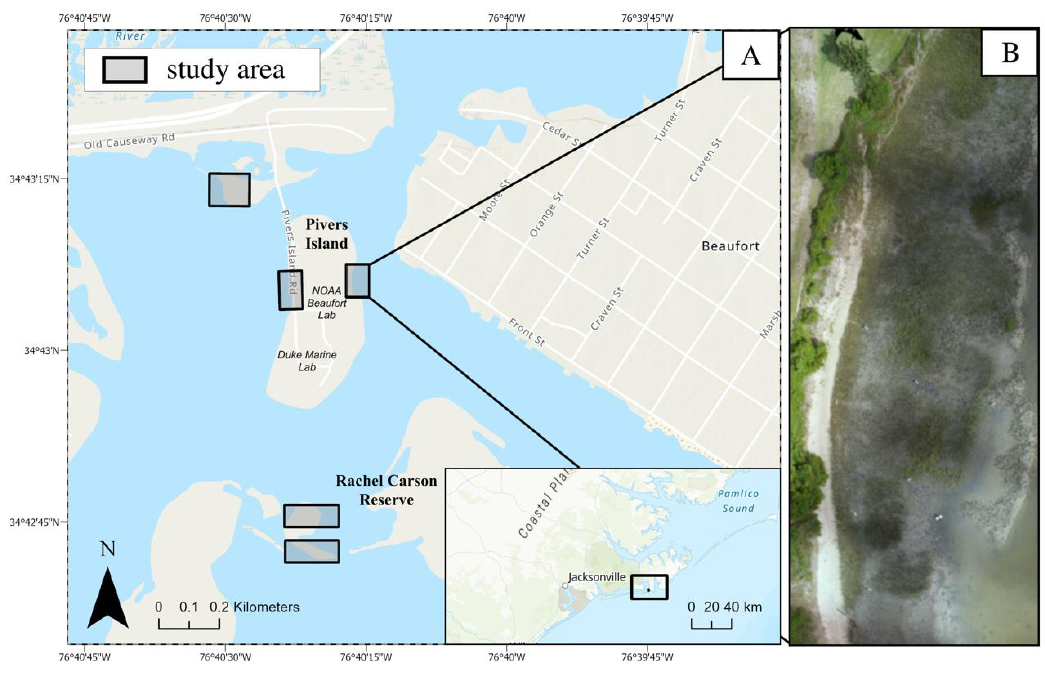
Figure 1. ( a ) Map of the location of five salt marshes sampled via Unoccupied Aircraft Systems (UAS) for Structure-from-Motion (SfM) photogrammetric vegetation height modeling. ( b ) Example site orthomosaic derived from SfM-photogrammetry of UAS imagery.